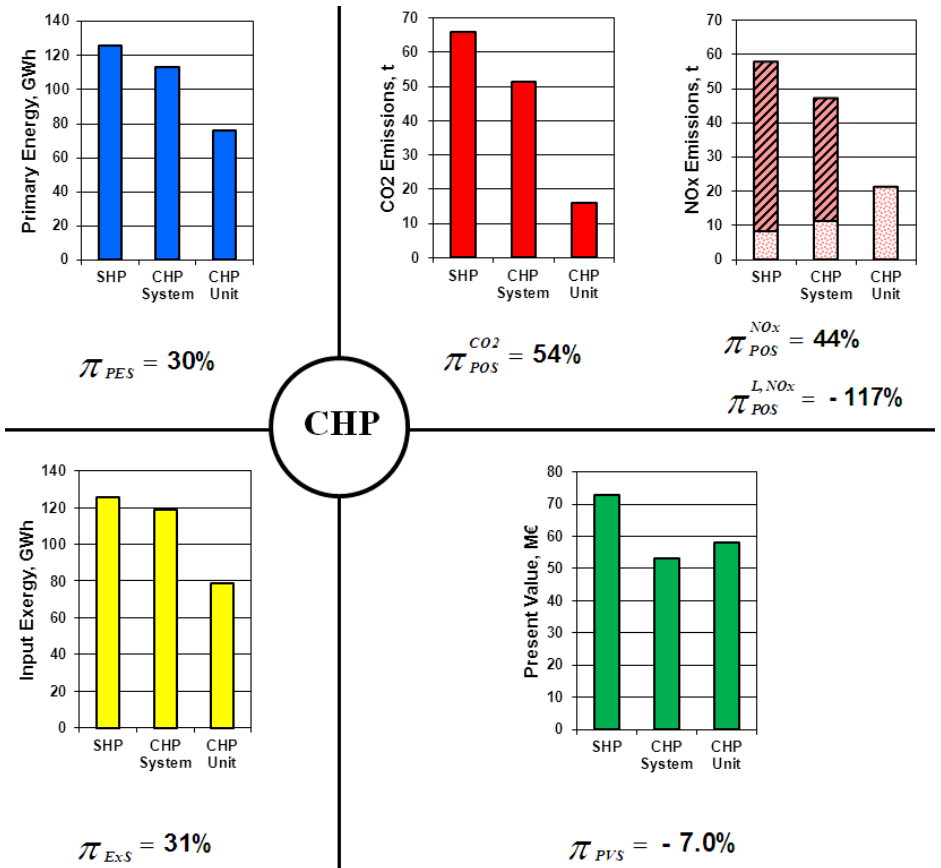
Figure 3. Case study results. Blue bars: primary energies; yellow bars: exergies; red bars: emissions (dotted bars refer to local scale); green bars: present